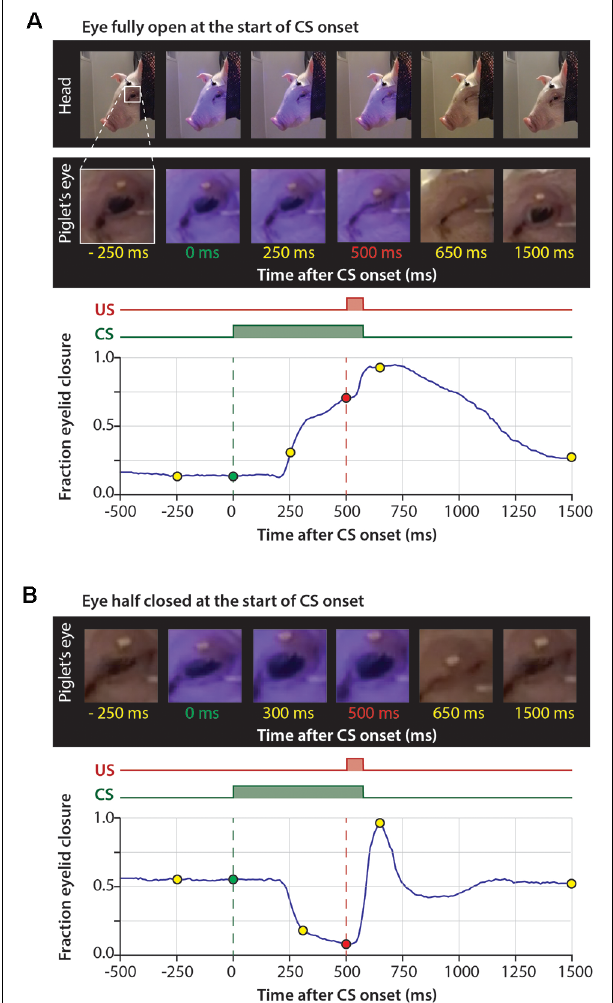
FIGURE 2 | Series of pictures during a trial and corresponding time-points in the eyelid trace. (A) The eye is fully open at the onset of the CS and there is no reaction to the CS. (B) The eye is half-closed at the onset of the CS and the eye opens in response to the CS. The blue LED used as a CS is reflected on the skin of the pig. Abbreviations: CS, conditional stimulus; US, unconditional